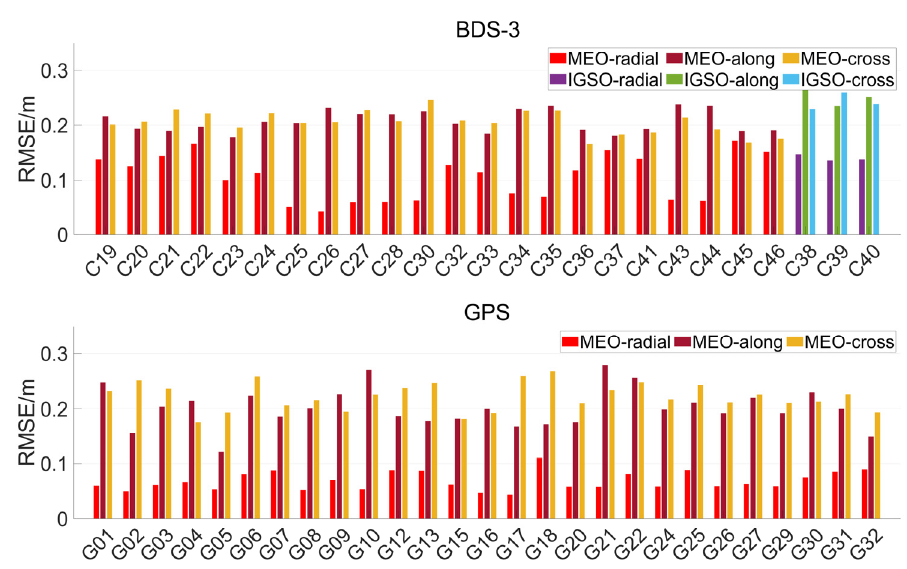
Figure 7. RMSE of the BDS-3 and GPS satellite orbits recovered with the PPP-B2b signals in the radial, along-, and cross-track directions using the GBM orbit products as a reference during DOY 168–198 in 2022.